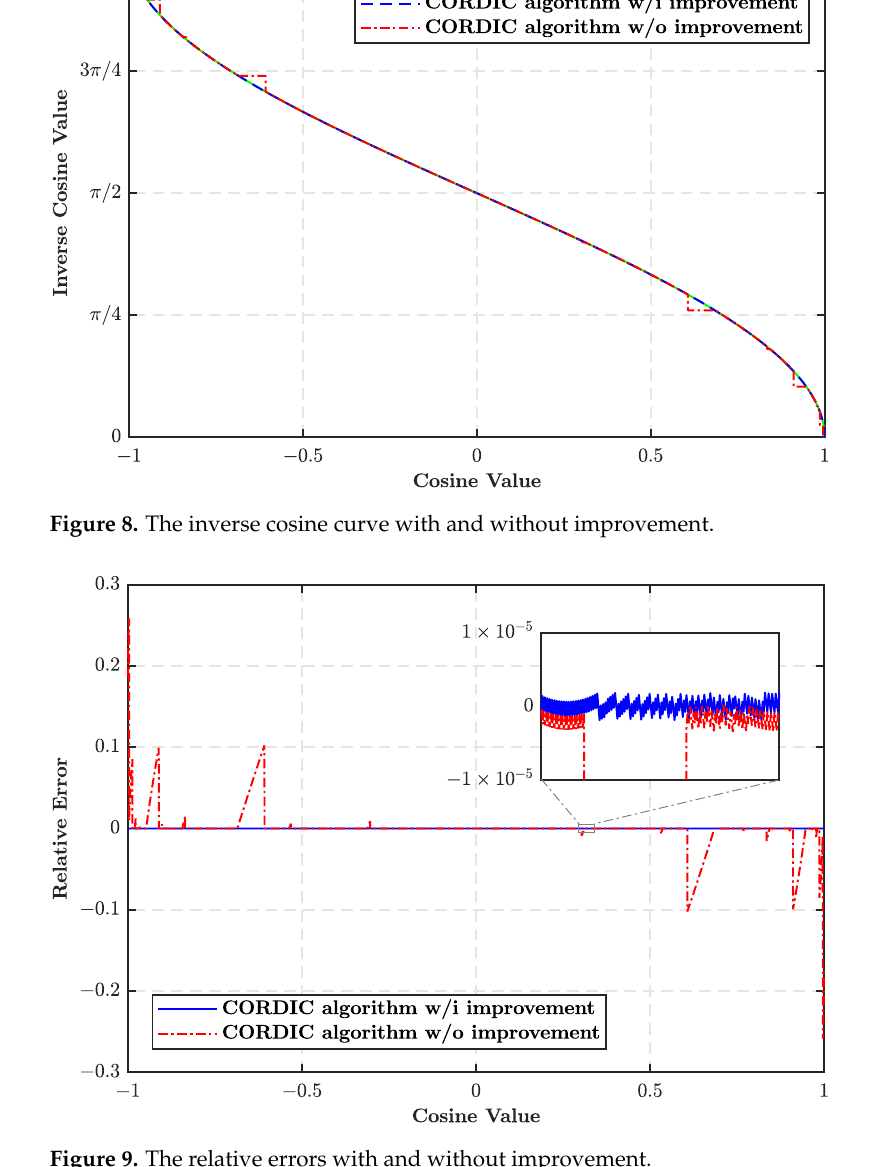
Figure 9. The relative errors with and without